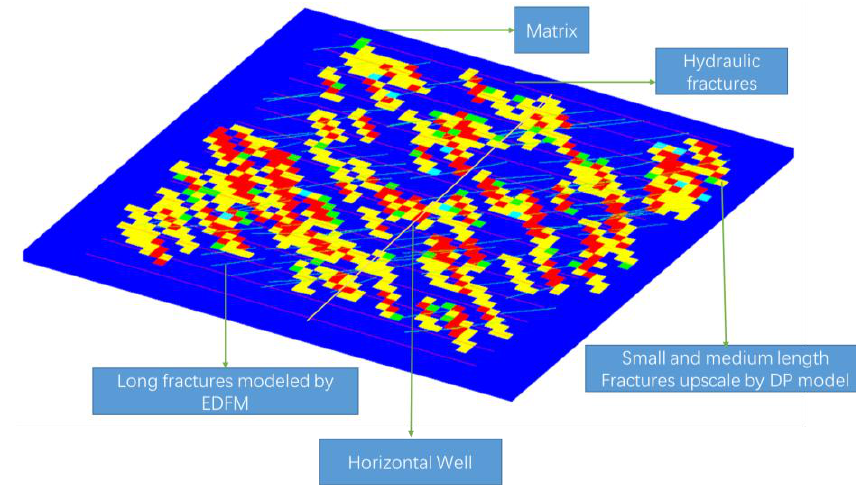
Figure 9. Natural fracture, hydraulic fracture distribution in reservoir.